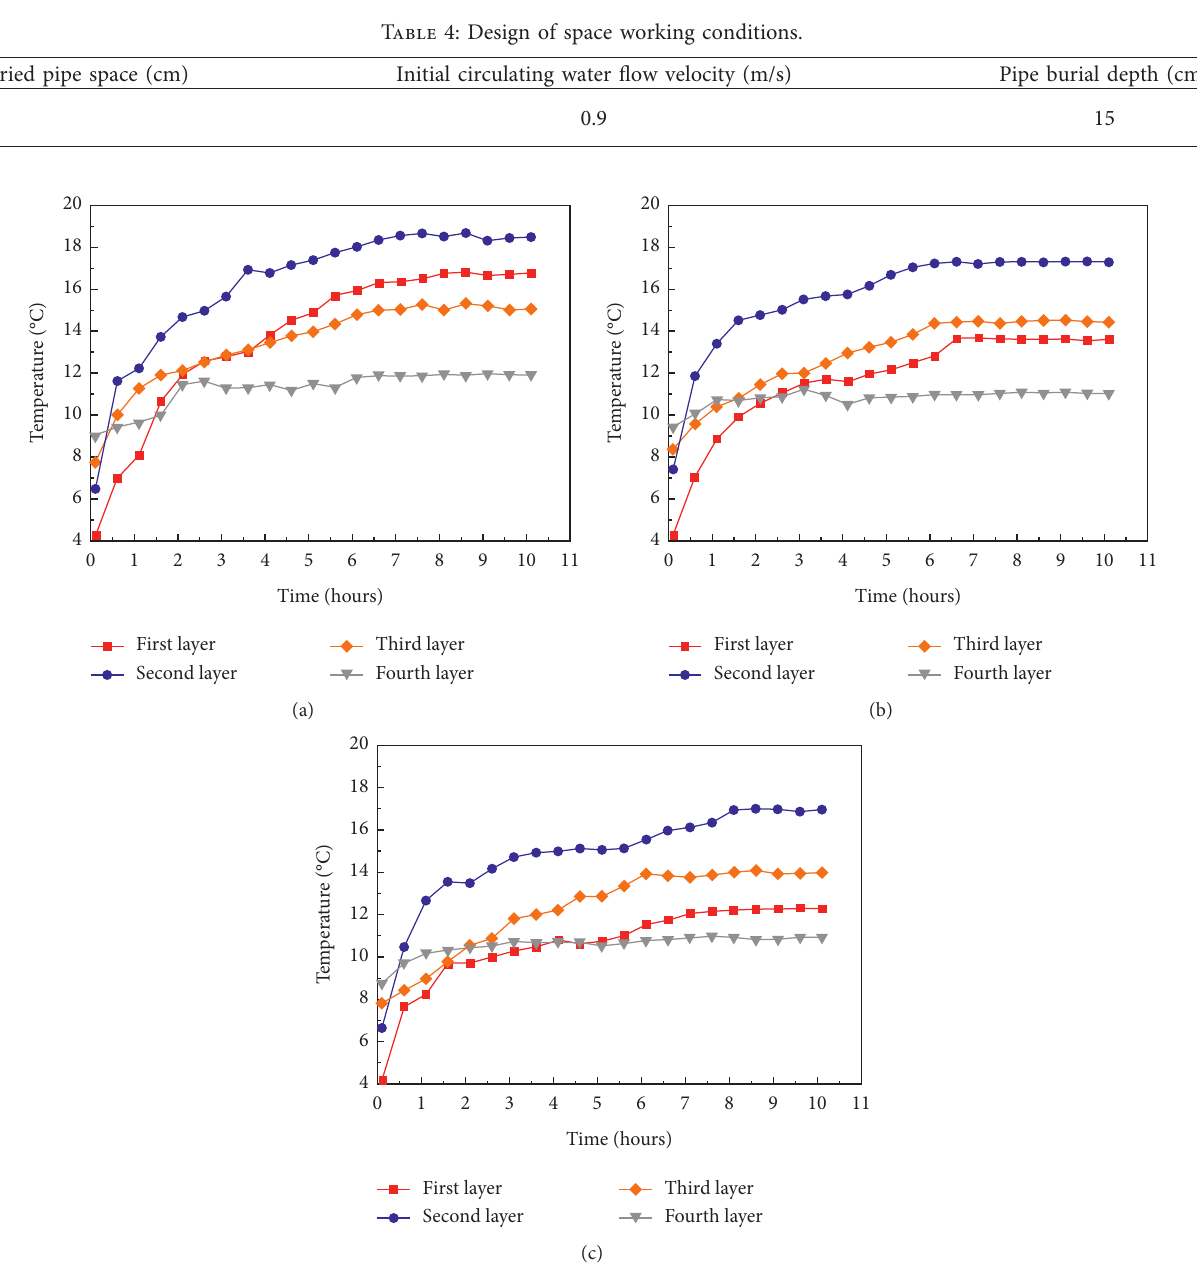
Figure 5: Temperature change curves of the measuring points of four layers under different flow velocities: (a) 0.8 m/s; (b) 0.85 m/s; (c) 0.9